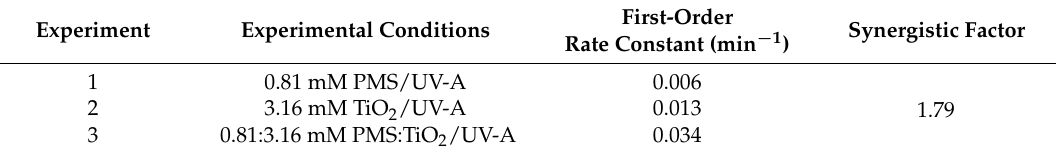
Table 4. Synergistic factor for PMS activation by TiO 2 and UV-A